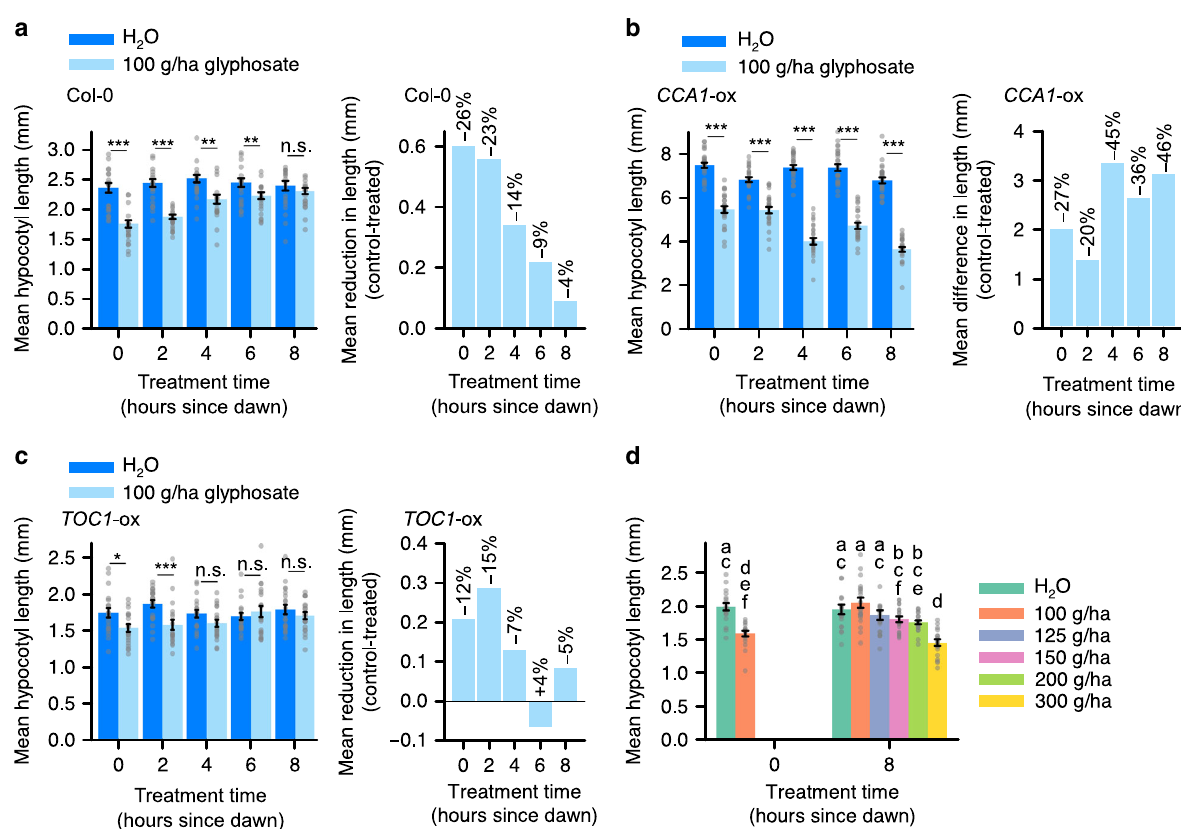
Fig. 1 Daily rhythms in glyphosate effectiveness. a – c Under light/dark cycles, hypocotyls are shorter in seedlings treated with 100 g/ha glyphosate compared with controls at times speci fi ed, in a Col-0, b CCA1 -ox and c TOC1 -ox seedlings. Graphs show (left) hypocotyl length and (right) change in hypocotyl length caused by glyphosate. d Titration of glyphosate concentration required to cause equivalent decrease in hypocotyl length at dawn and dusk in the Col-0 background. a – d Signi fi cance determined by a – c two-way ANOVA and t -tests between control and treatment at each timepoint; d one- way ANOVA and Tukey post-hoc analysis. n.s. = not statistically signi fi cant, * P ≤ 0.05, ** P ≤ 0.01, *** P ≤ 0.001. Data are mean ± s.e.m; n = 18 – 25. Source data are provided in the Source Data fi (Fig. 1a – c). These differing responses of CCA1 -ox and TOC1 -ox to glyphosate might re fl ect differences in their elongation response to light compared with the wild type 25 . Reduction of hypocotyl length was caused by glyphosate, not the herbicide adjuvants (Supplementary Fig. 3E). Together, this indicates that the circadian oscillator underlies a daily rhythm in glyphosate ef fi cacy under light/dark cycles.